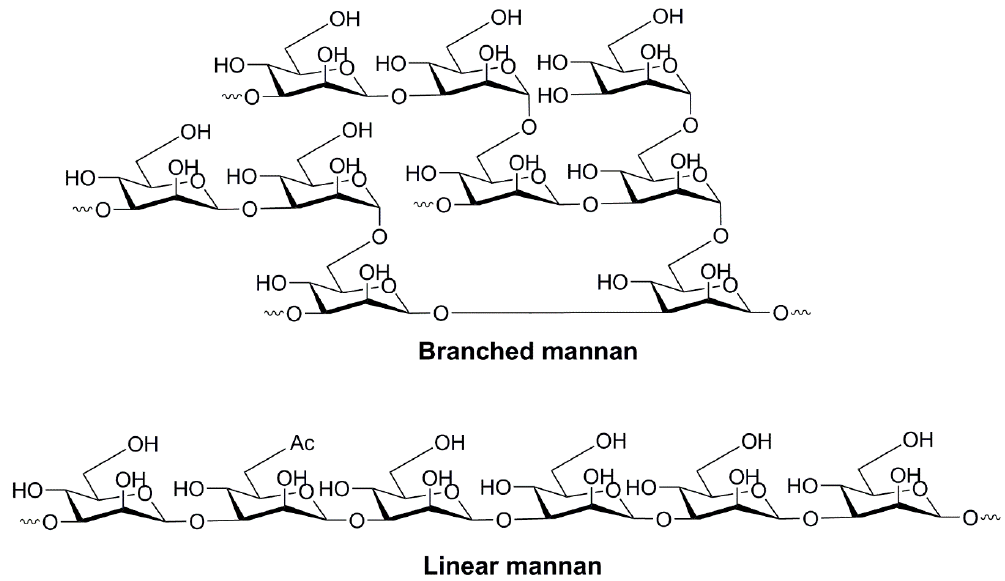
Figure 4. The branched and linear forms of mannan.